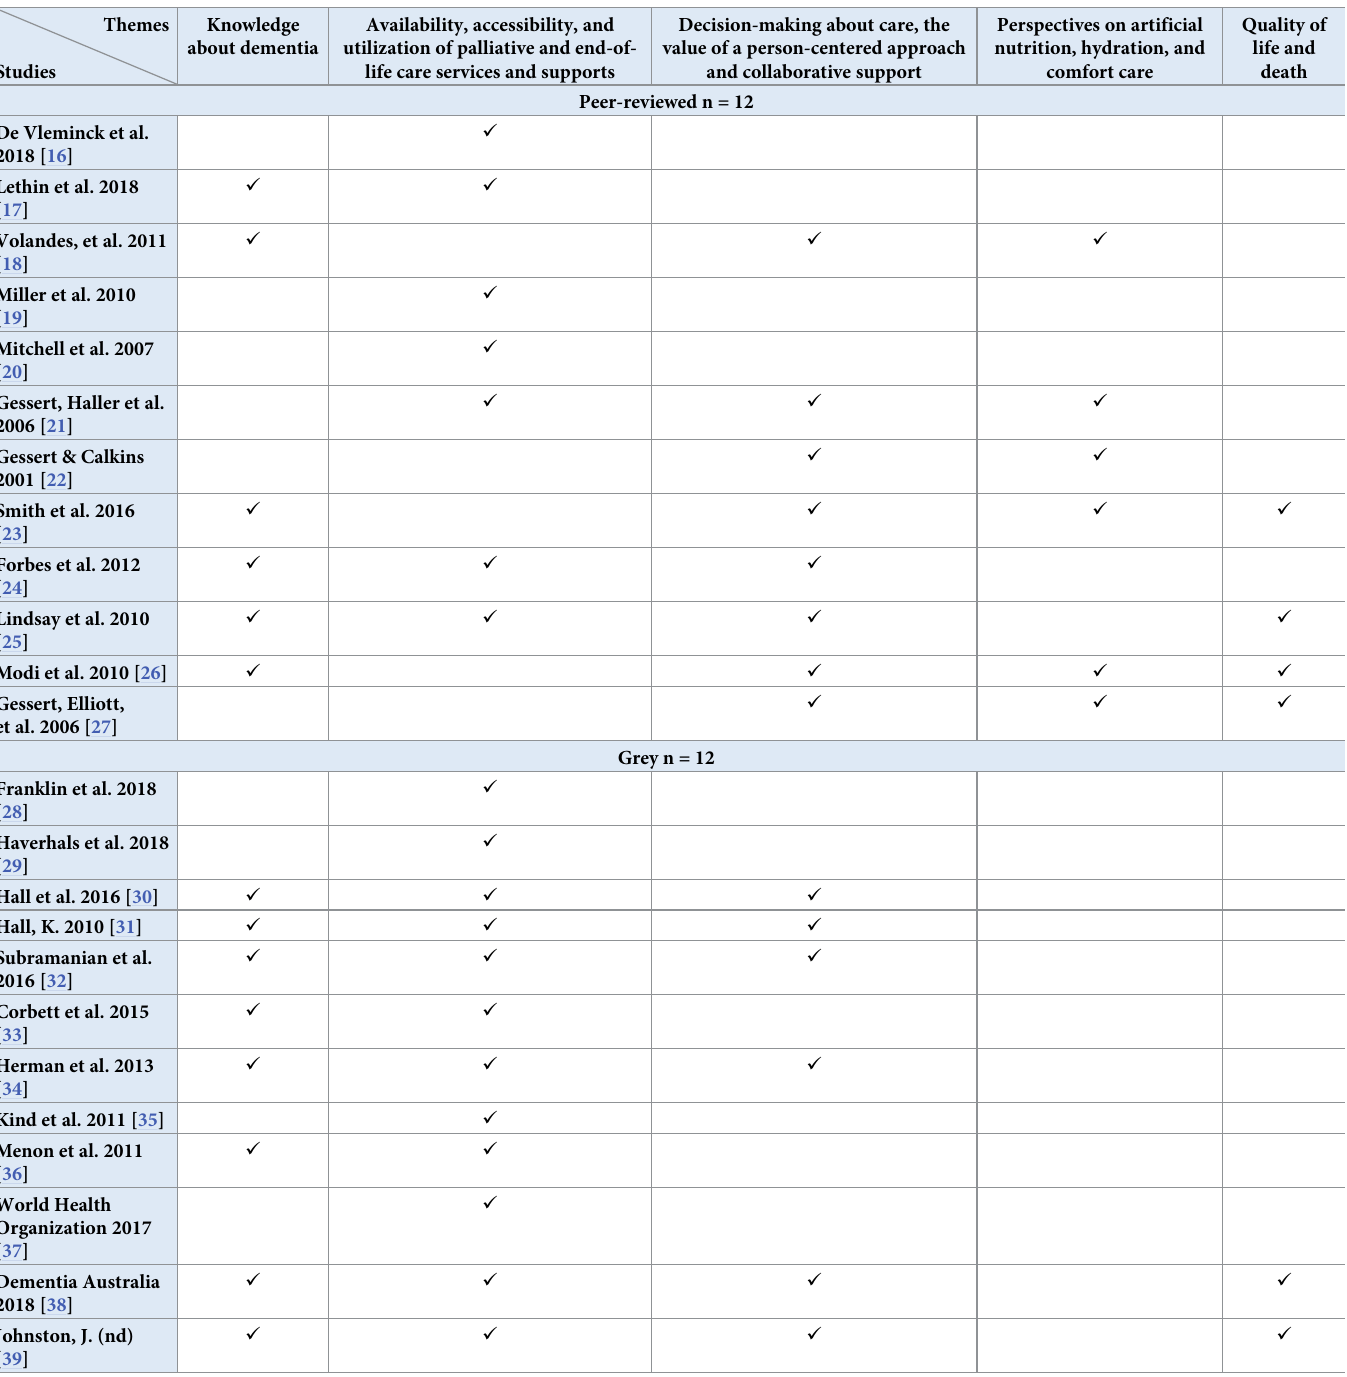
Table 4. Peer-reviewed and grey literature mapped to